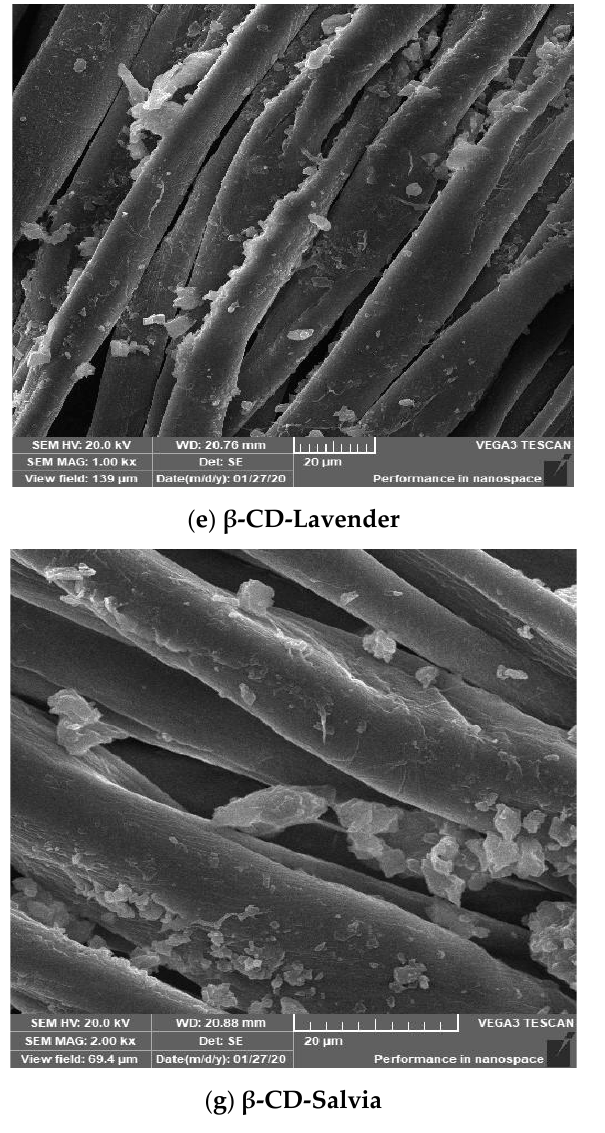
Table 1. Antibacterial activity and durability properties for different fabrics’ treatments against dif- ferent bacterial species.